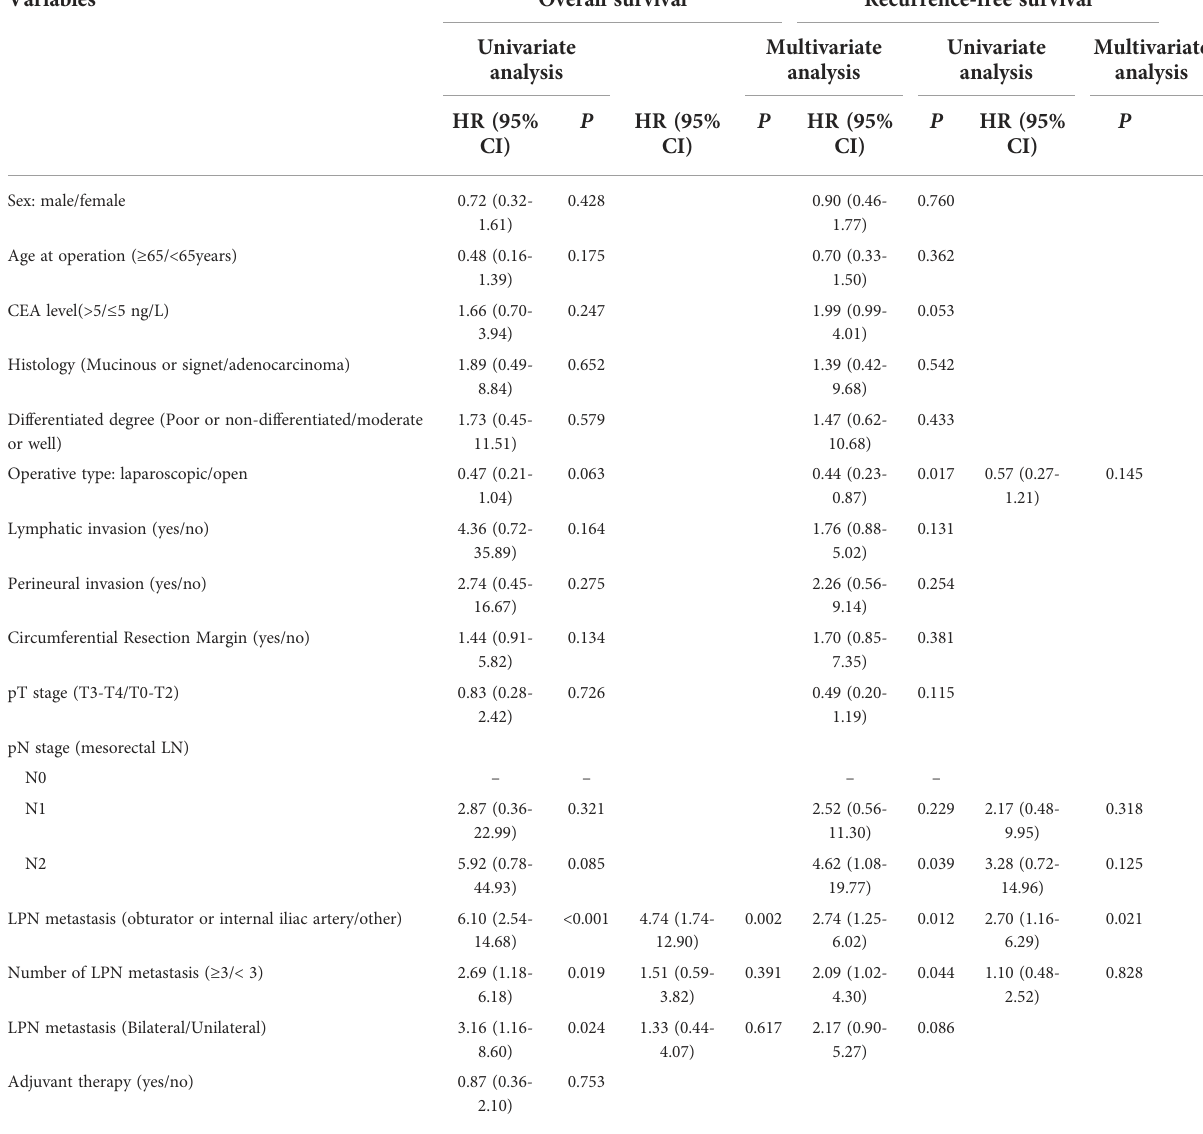
TABLE 7 Univariate and multivariate regression analyses of 91 patients with pathological LPN metastasis.